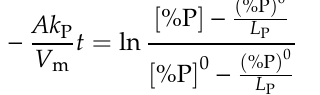
Figure 7. Mass transfer resistance of phosphorus in steel and slag A.